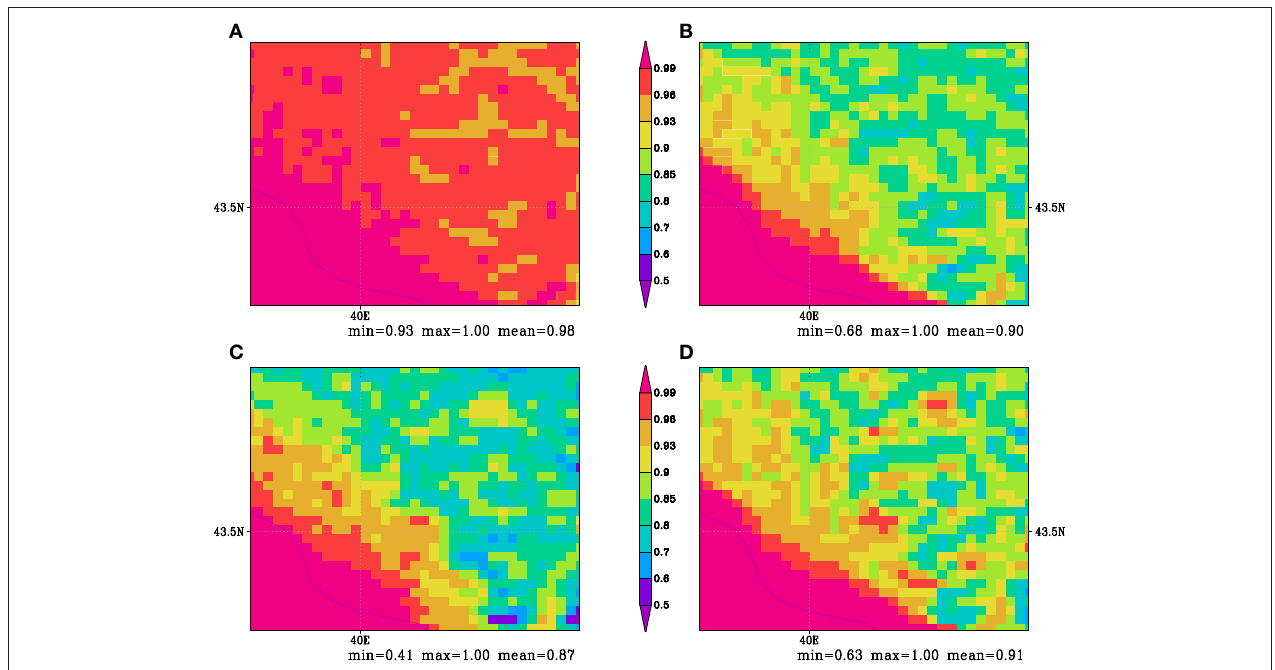
FIGURE 4 | Sky view factor δ sv (fraction from 0 to 1 shown by the color scale) zoomed to the Olympic venue: (A) based on local horizon angle obtained with the distance-dependent weighting, (B) STRM-level estimate without weighting of the horizon angle, (C) δ aggregation-level estimate according to SRS7 definition. The approximate coastline is indicated in the lower left part of the figures, latitude 43.5N and longitude 40E are marked into the